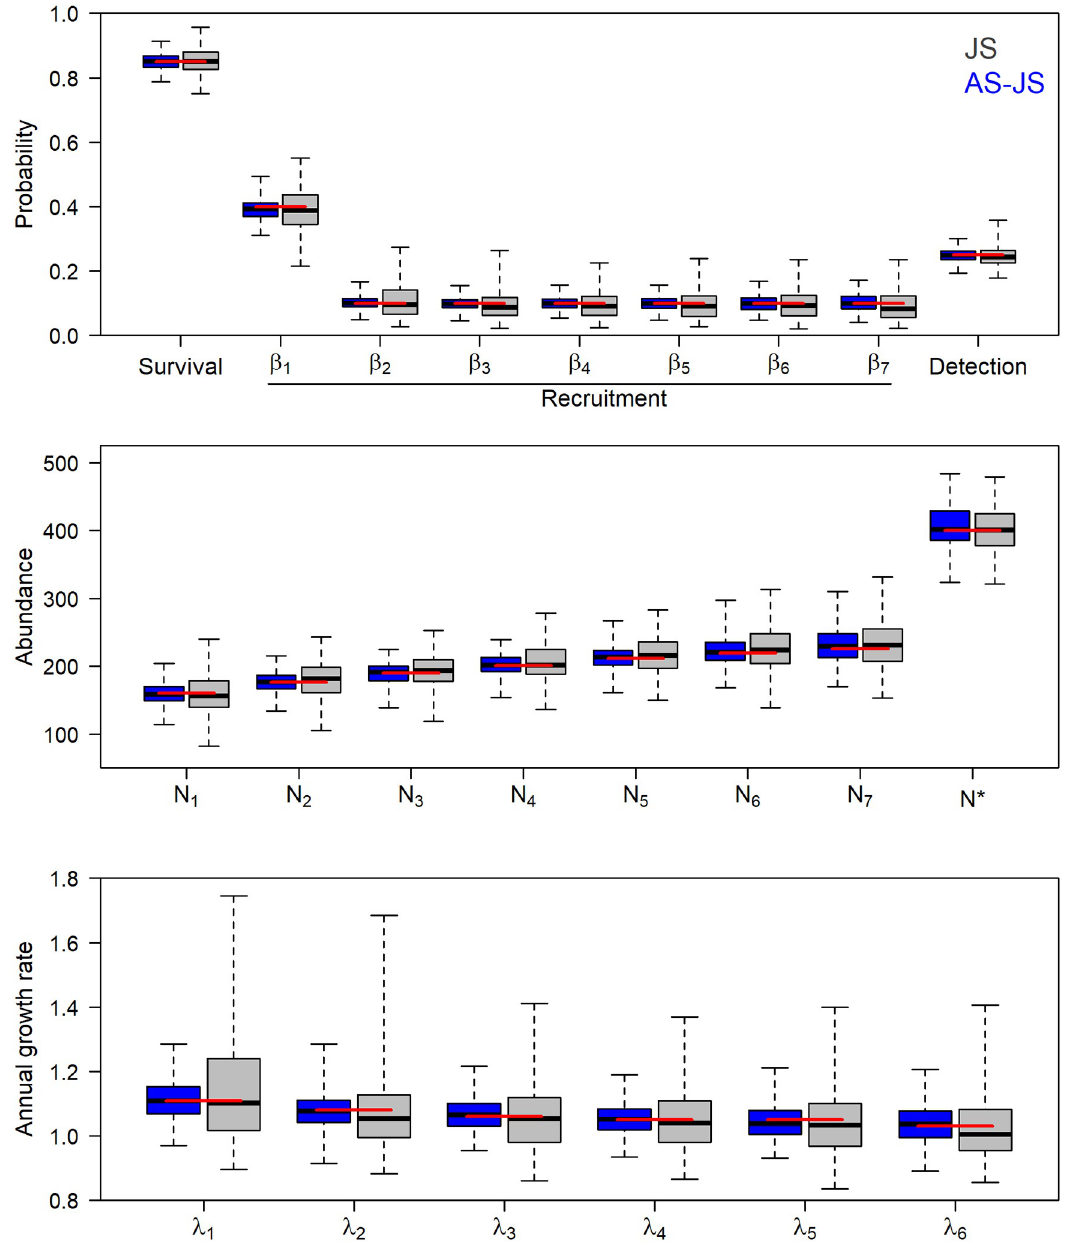
Fig 1. Boxplots of posterior medians for survival, recruitment, and detection (top), abundances (middle), and annual population growth rates (bottom) from 200 simulated data sets analyzed using Jolly-Seber models that ignore (grey) or incorporate (blue) age structure. Boxplots include medians (black line), interquartile range (box), and range of values (whiskers). Red horizontal lines denote data generating values. Data generation fixed the maximum age in year 1 ( J ) at 9, but age structure analyses assumed J = 10 to evaluate robustness to uncertainty in maximum